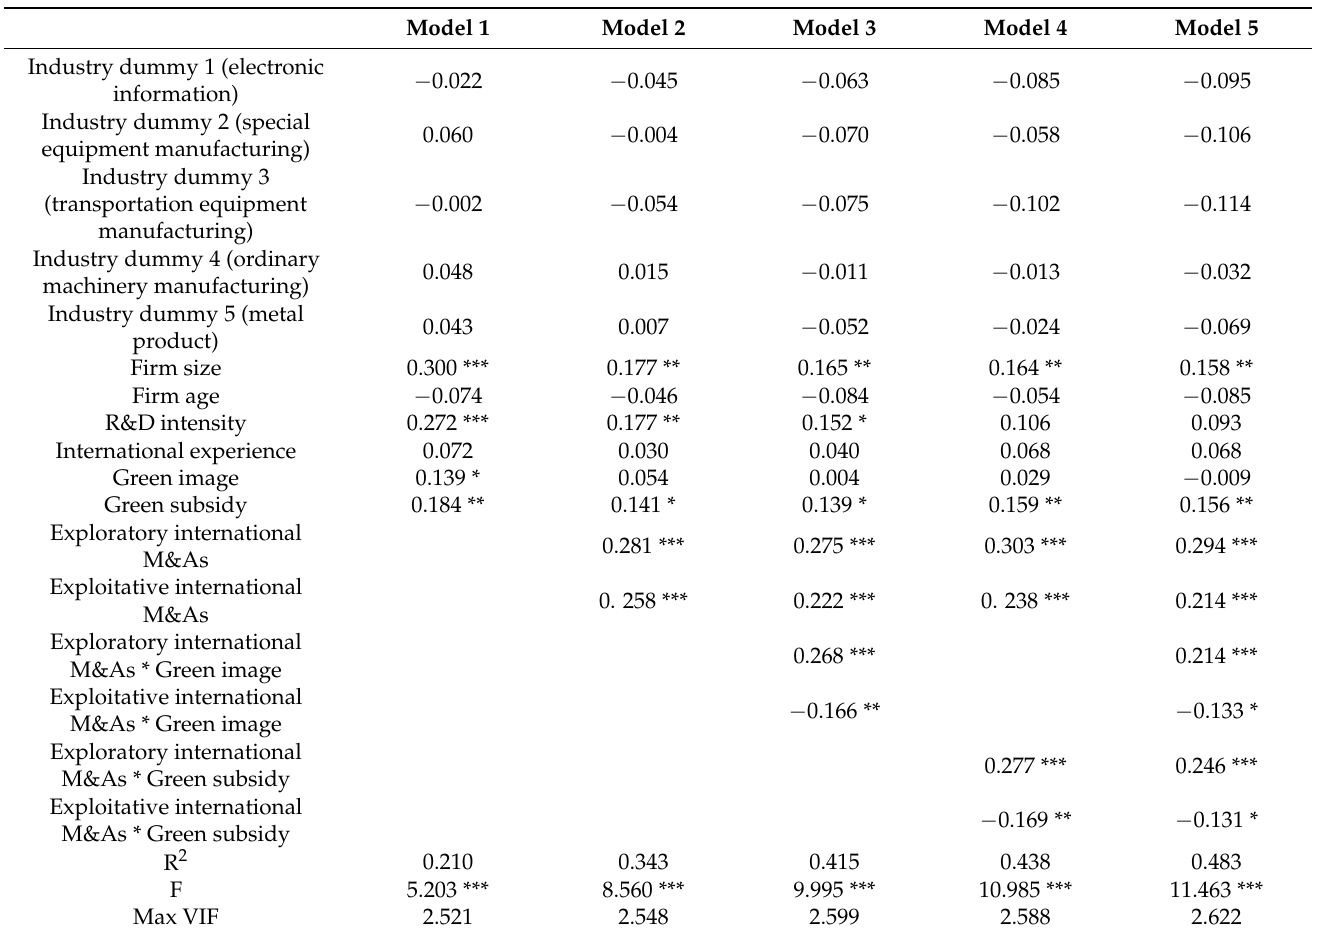
Table 3. Results of moderated regression